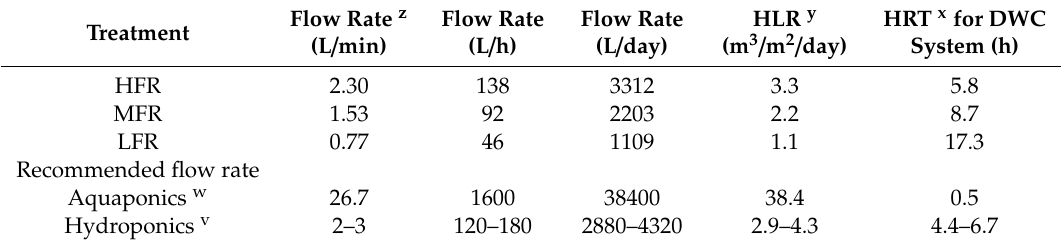
Figure 1. Schematic diagram of the experimental aquaponic system adapted from Yang and Kim (2019). Table 1. Flow ‐ rate treatments, high (HFR, 3.3 m/day), medium (MFR, 2.2 m/day), and low (LFR, 1.1